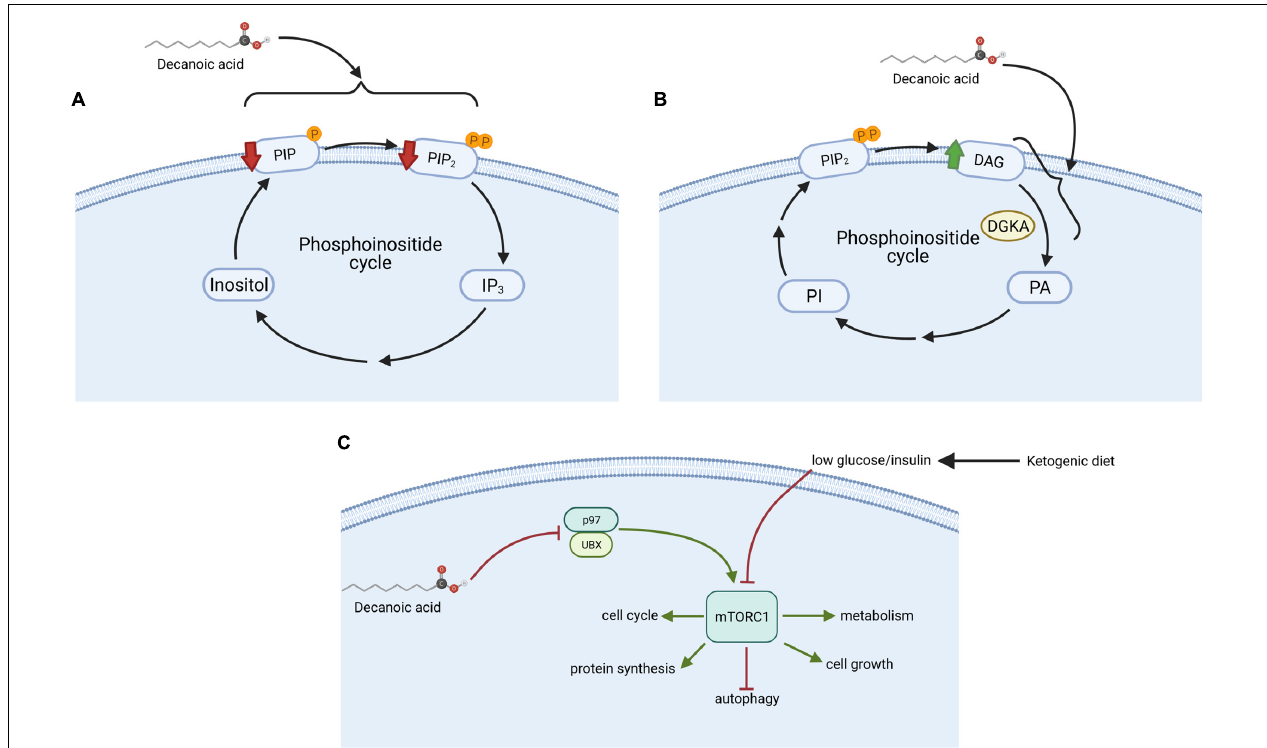
FIGURE 2 | Mechanisms of action of decanoic acid identified in D. discoideum . (A) Decanoic acid regulates the phosphoinositide pathway by decreasing phosphatidylinositol phosphate (PIP) and phosphatidylinositol diphosphate (PIP 2 ) concentrations; (B) increased diacylglycerol (DAG) levels through the inhibition